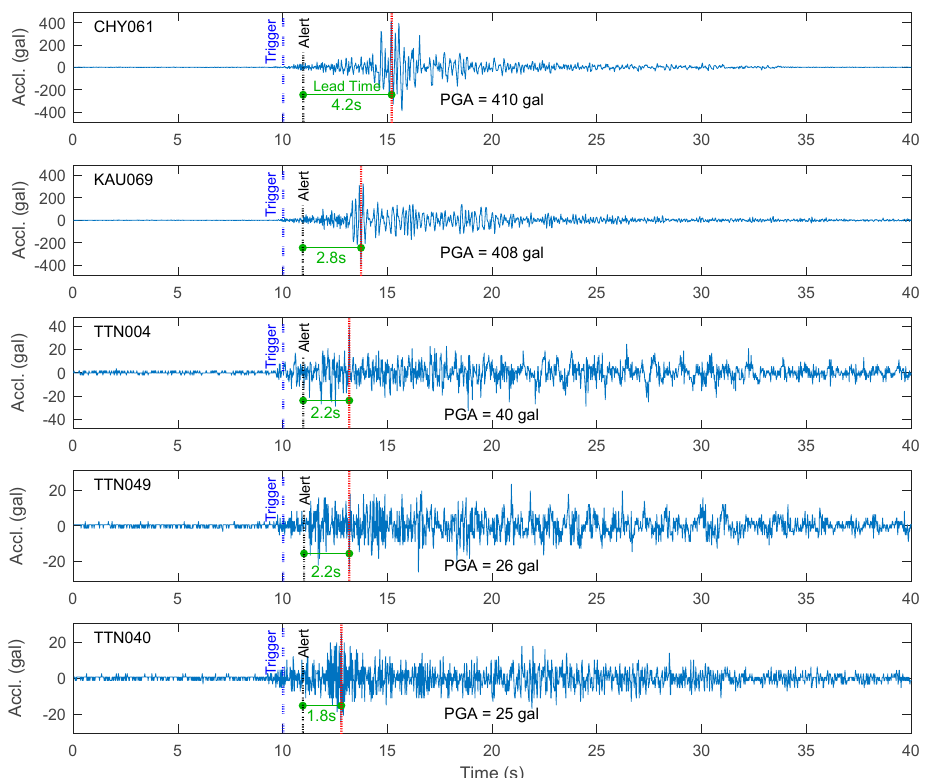
Figure 14. The typical five time histories with the shortest lead time for the Meinong earthquake dataset using the LG Stylus smartphone.